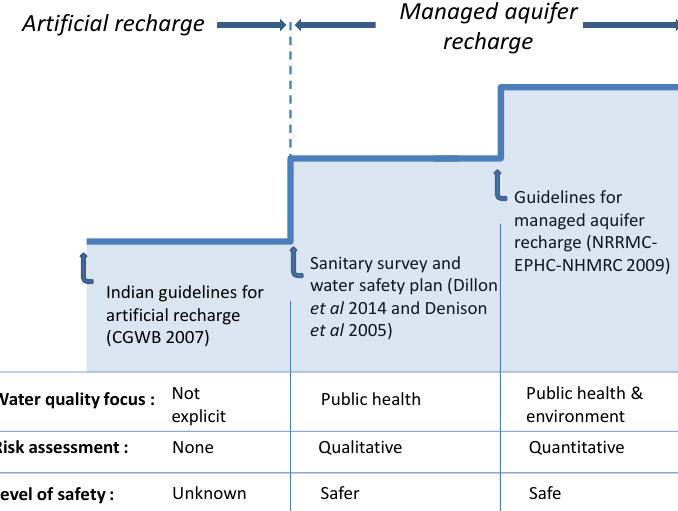
Figure 5. Implementing the Australian MAR Guidelines in India was not possible due to limitations in availability of analyses for viruses and protozoa in environmental water samples and difficulty in being able to get samples from field sites to the lab in time and at a correct temperature for reliable analytical results. Solid state extraction could enable viable delayed analyses of water samples. Hence, an Indian Guideline for MAR was prepared (Dillon et al. 2014) [62] as a step towards safer water supplies and improved groundwater protection than current practice, but without the rigor of data acquisition to support a risk assessment necessary to assure safety.